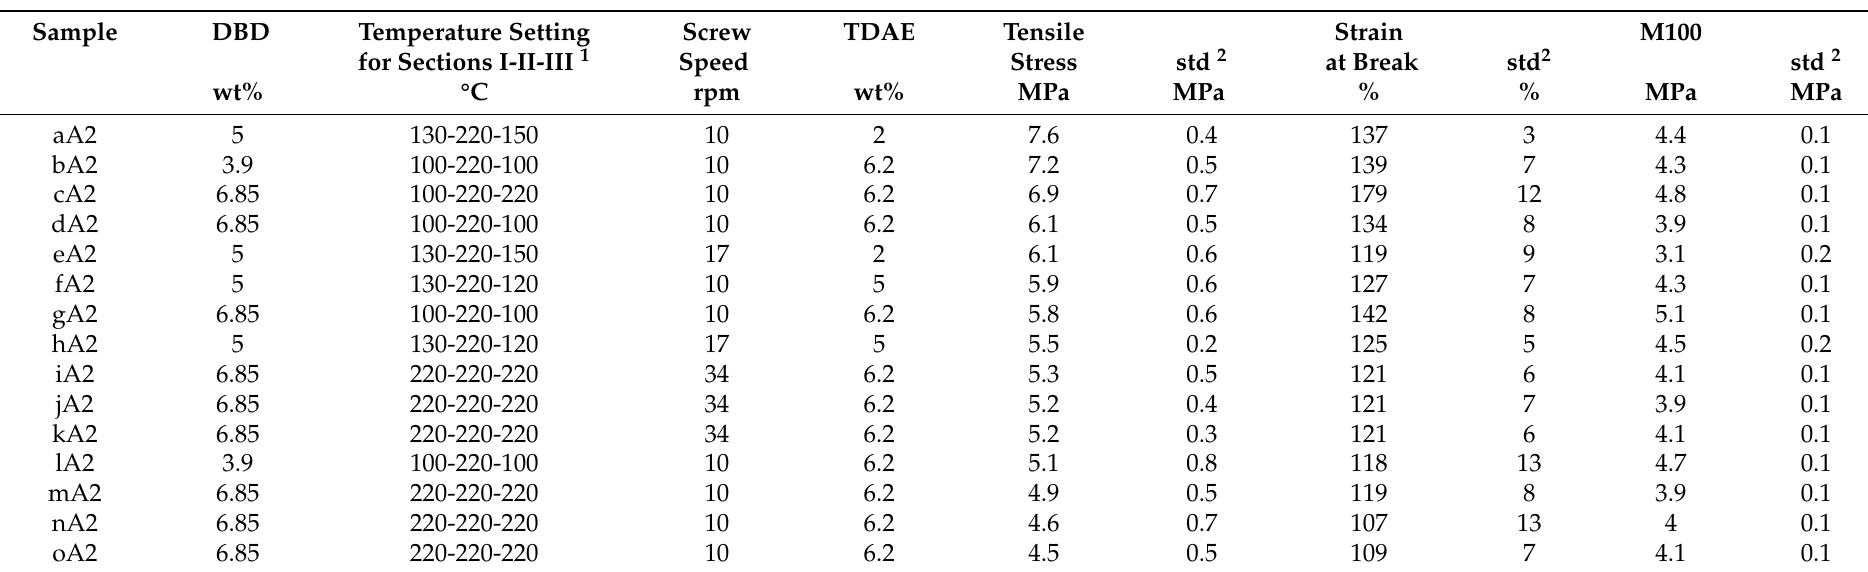
Table 3. Tensile values after re-vulcanization with a silica-silane based formulation. Values after de-vulcanization using screw A , revulcanized with formulation II , Table A3. Sample